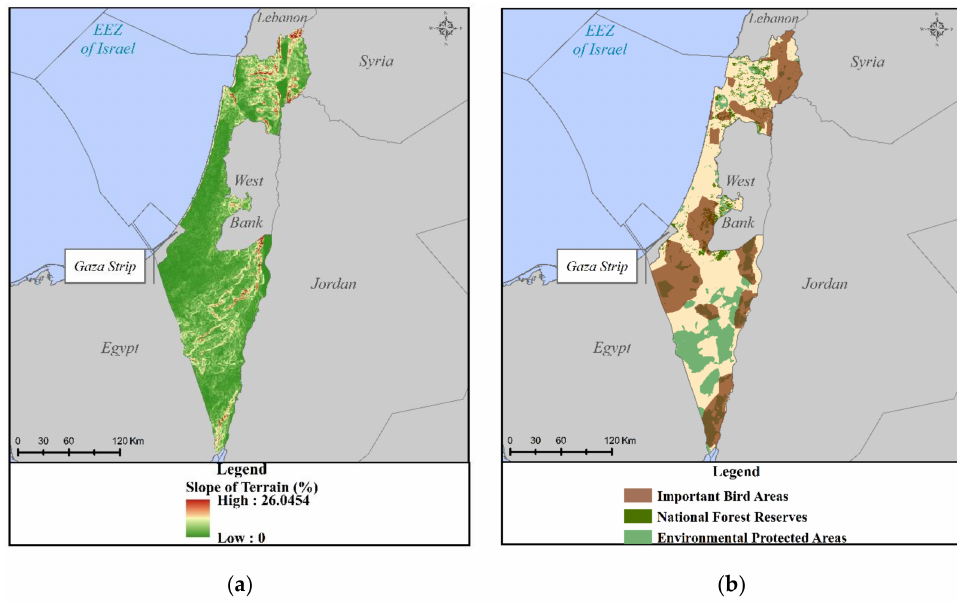
Figure 6. Thematic maps of ( a ) Slope of Terrain (WSC.2/SSC.3) and ( b ) Distance from Land Protected Areas (WSC.8/SSC.9) and Distance from Importance Bird Areas (WSC.17) as defined in Table 1.